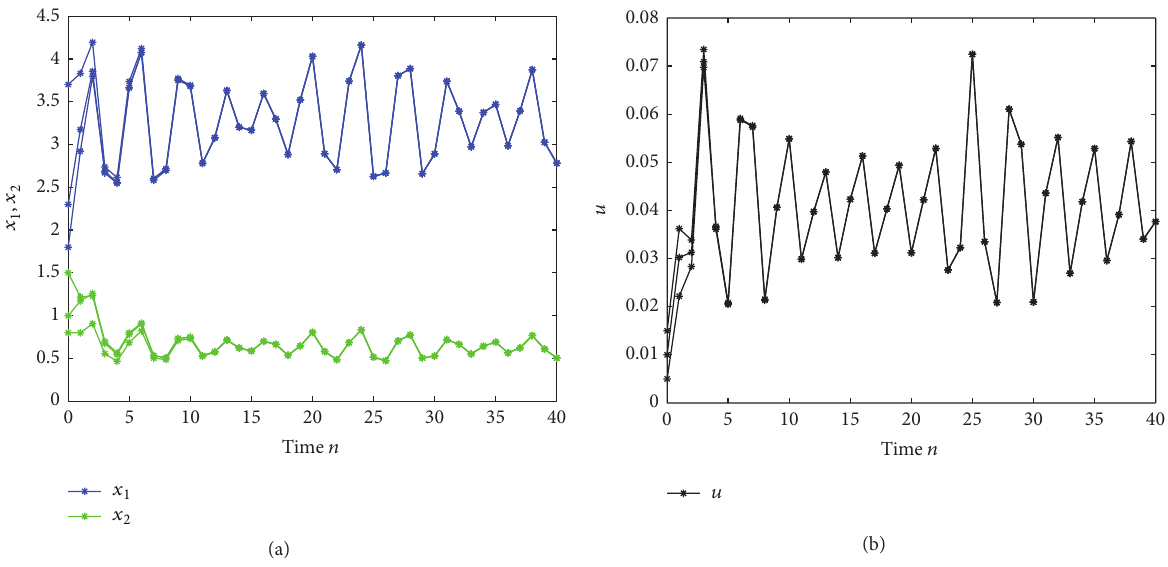
Figure 1: Numeric simulations of the solutions (𝑥 1 (𝑛), 𝑥 2 (𝑛),𝑢(𝑛)) of system (103), with the initial conditions (𝑥 1 (𝑠),𝑥 2 (𝑠),𝑢(𝑠)) = (1.8, 1, 0.005) , (2.3, 1.5, 0.01) , and (3.7, 0.8, 0.015) , 𝑠 = ⋅⋅⋅ ,−𝑛,−𝑛 + 1,...,−1,0 ,